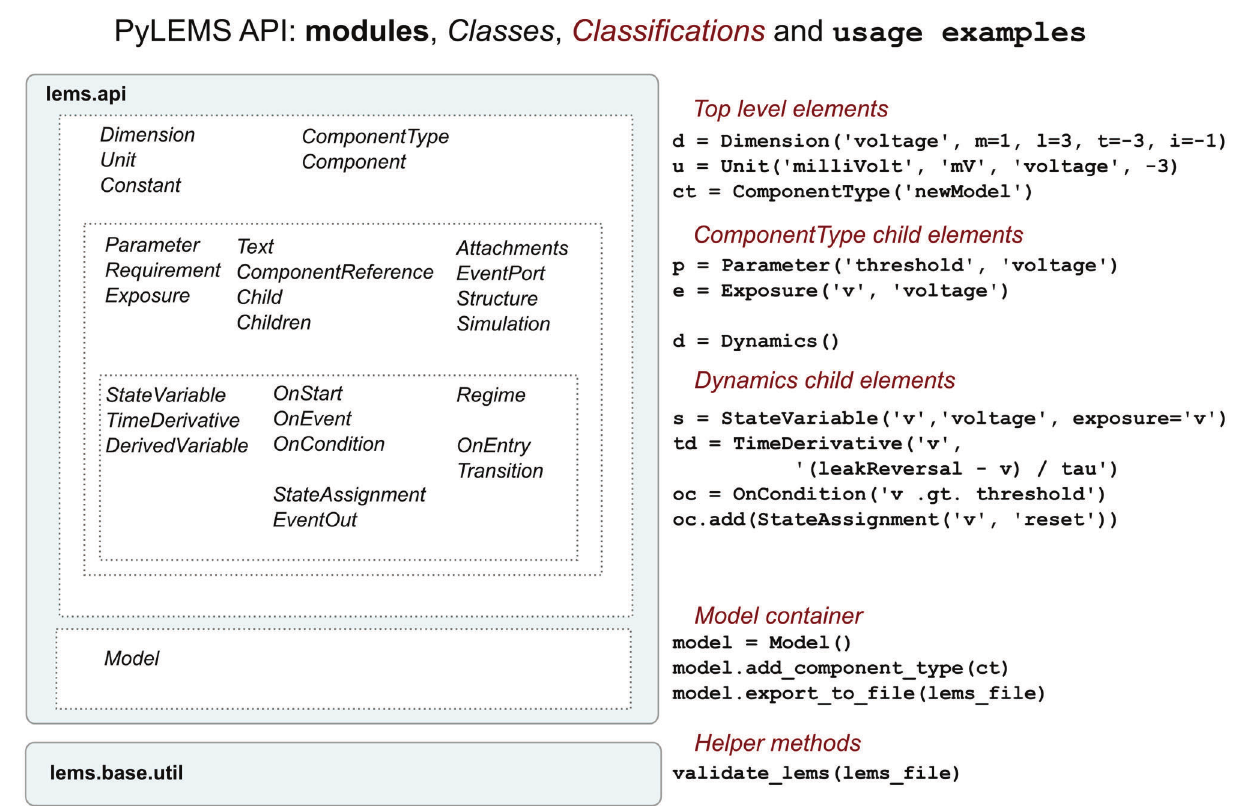
FIGURE 5 | An overview of the structure of the PyLEMS API. Classes are present for each of the main elements of the LEMS language (left). Examples of using these in a Python script are shown on the right. The Model class is a container which can be used to hold the model and